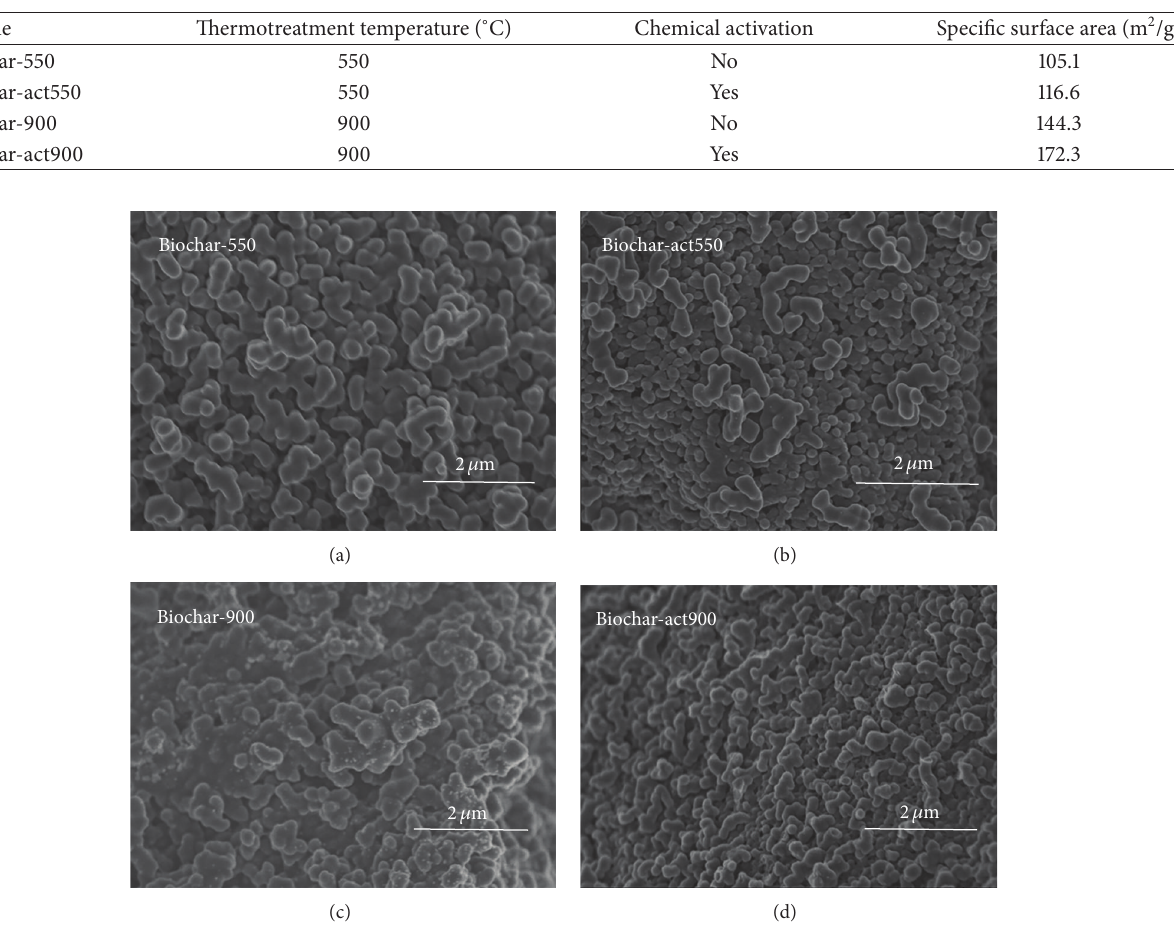
Figure 4: SEM images of the biochar at different hydrothermal carbonization and after chemical